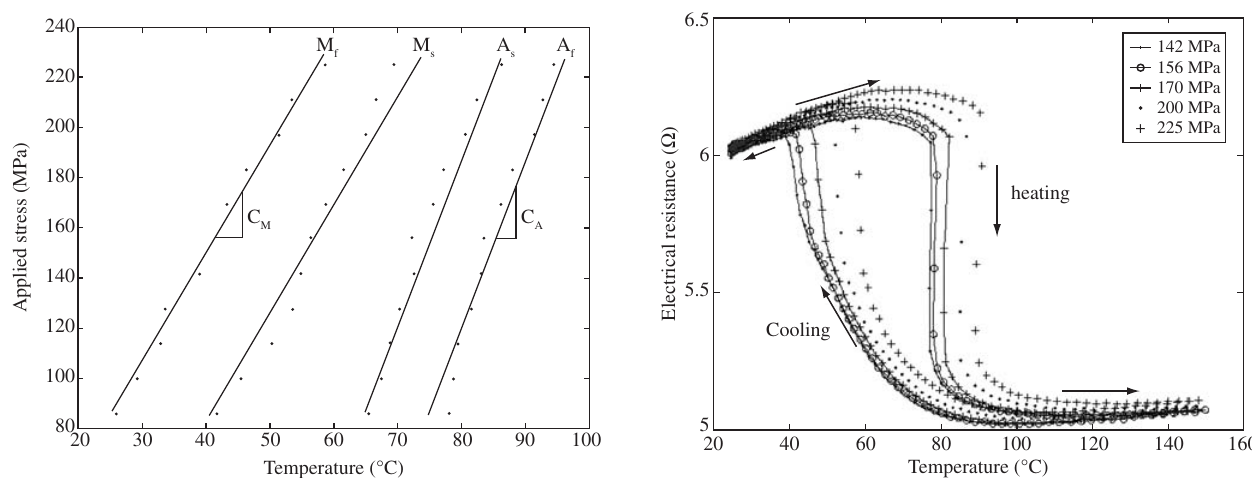
Figure 9. R - T hysteresis loops for some applied loads on the SMA